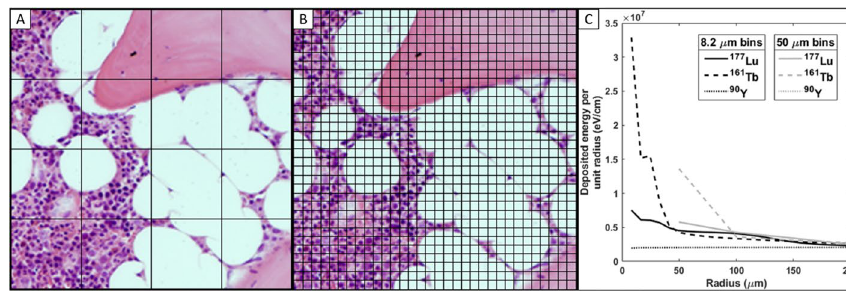
Fig. 5 Visualization of two pixel grids corresponding to 50 µm A and 8.2 µm B on top of a spongiosa biopsy. C Point-source energy deposition in the first 200 µm for the three studied radionuclides in a voxel grid of 8.2 µm (solid) and 50 µm (dashed)